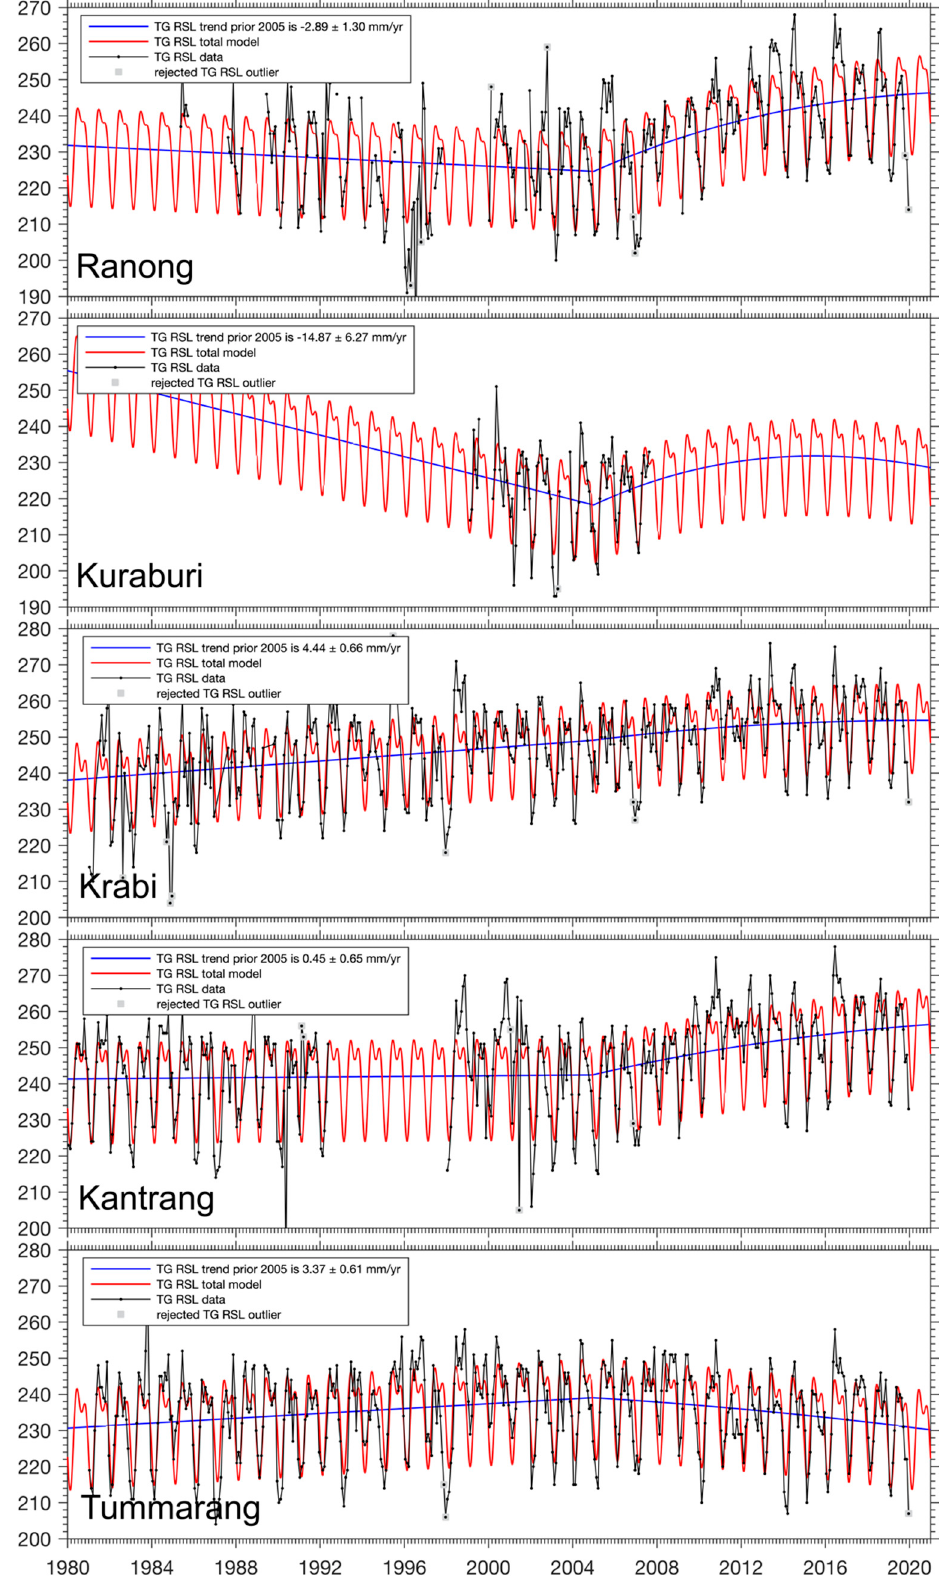
Figure 8. The relative sea-level changes recorded by the TMD TG stations (1980–2020) in the south of Thailand ( Y- axis in cm, X- axis in years ). Trends are indicated by the blue lines and have been estimated by a robust fit of a parametric model consisting of bias, trend, and annual and semi-annual periodic signals . In addition, here a distinction is made for the tide-gauge data following the Mw 9 . 2 Sumatra − Andaman earthquake (26/12/2004), where in addition to a linear trend an exponential